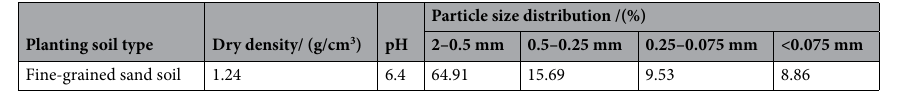
Table 1. Basic properties of planting soil.